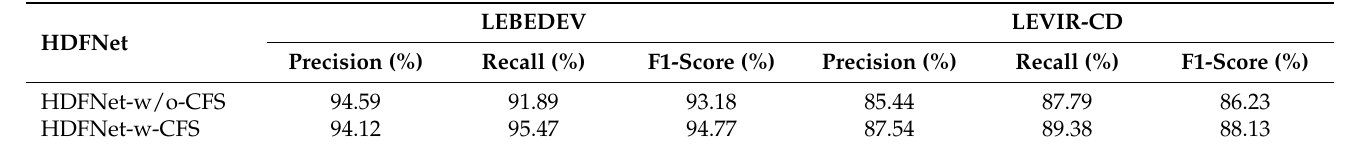
Table 3. Ablation study of with/without cross fusion stream.